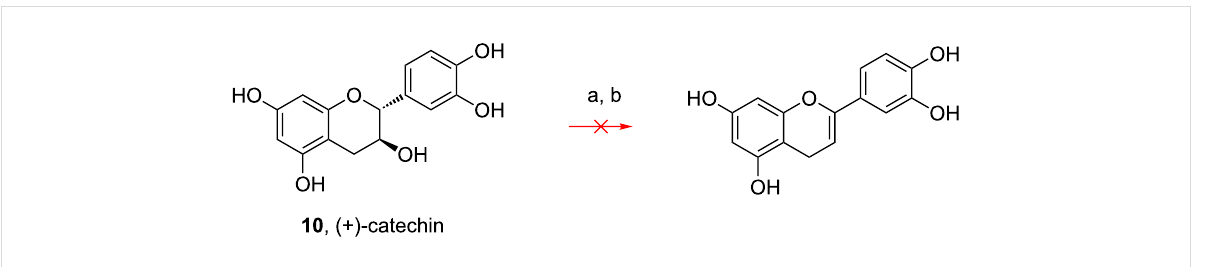
Figure 3: Putative mechanism of dehydration of flavanonols under Mitsunobu conditions.